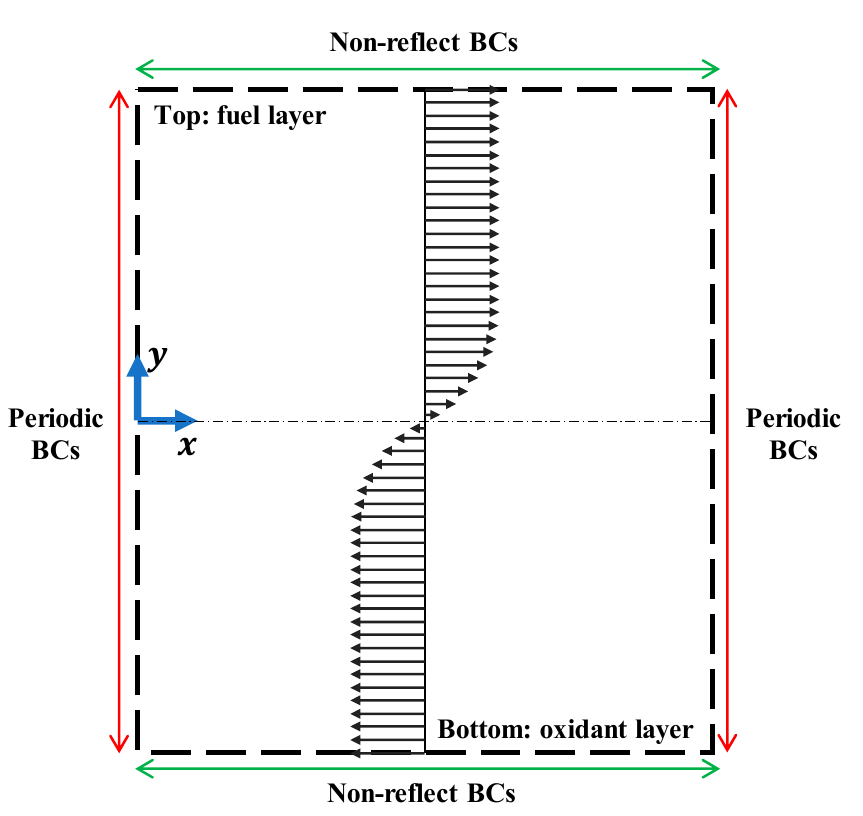
Figure 1. Diagram of the temporal developing mixing layer.